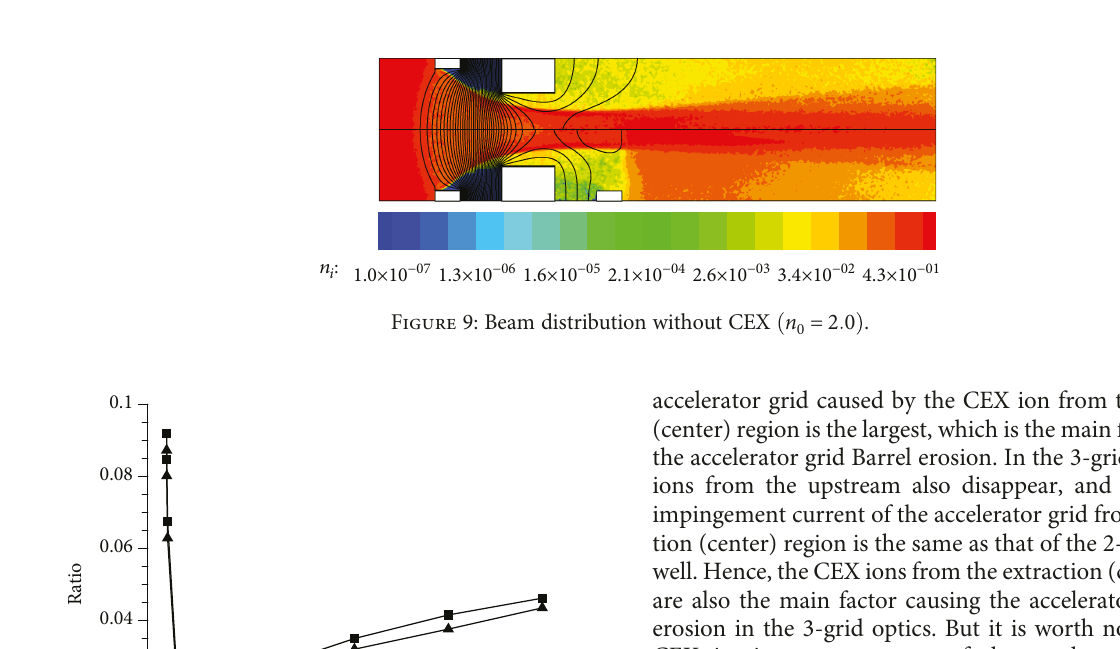
Figure 8: Beam distribution with CEX n